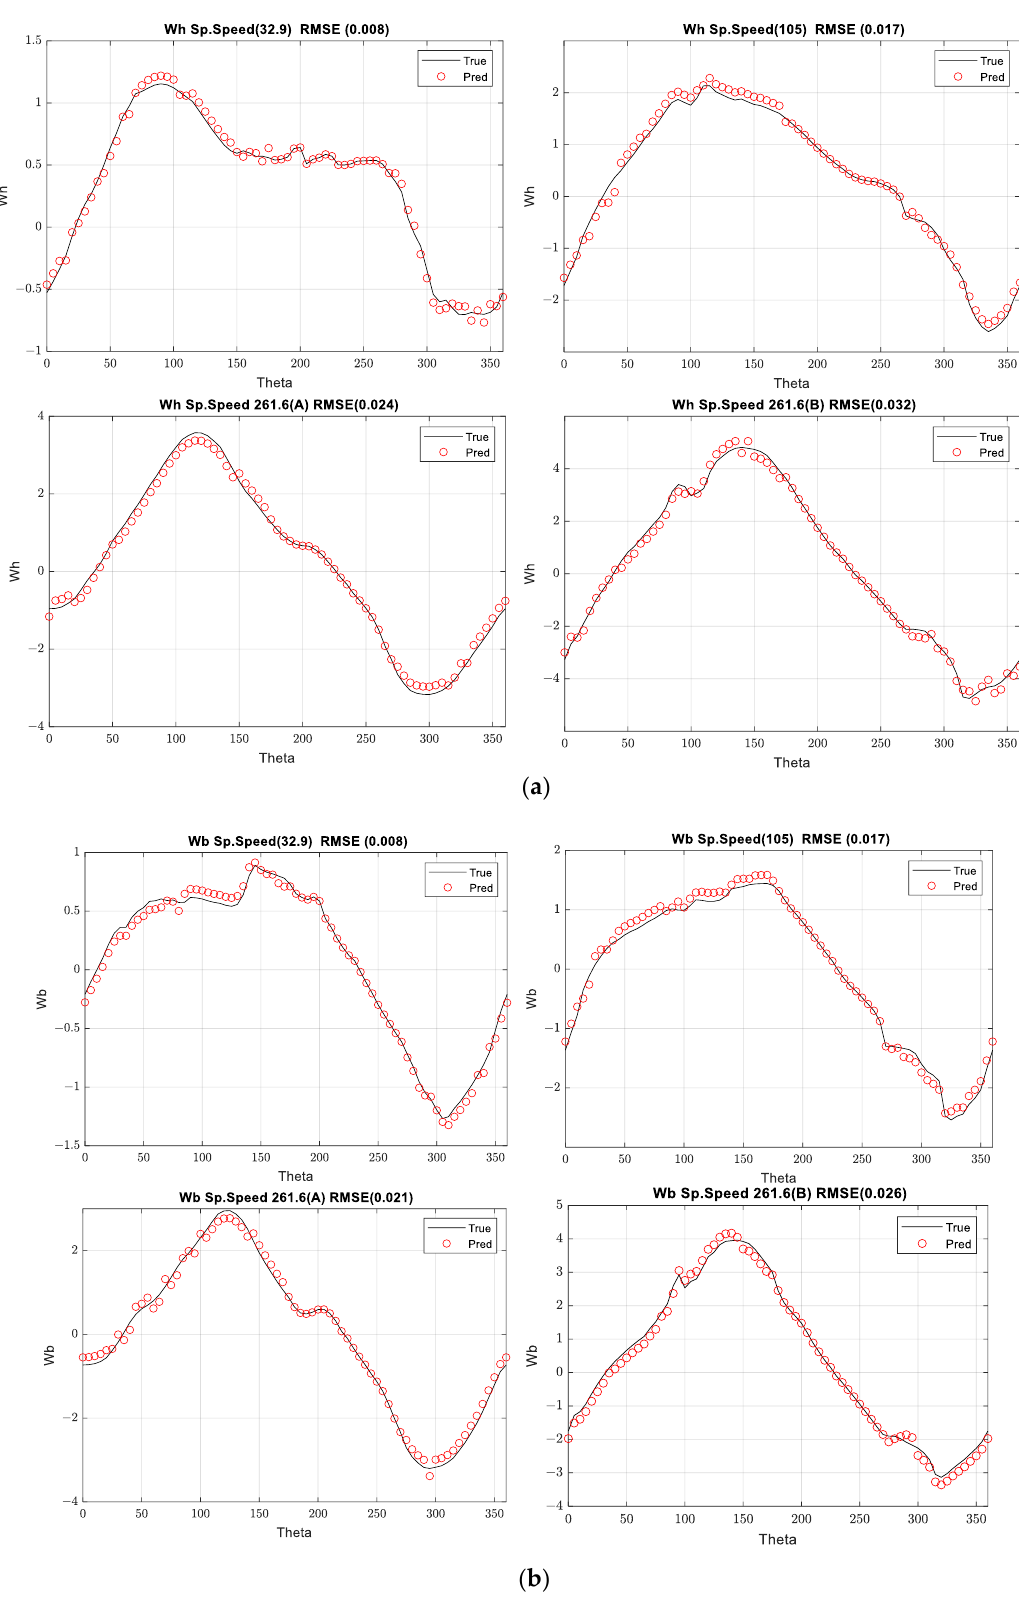
Figure 6. ( a ) Predicted dimensionless head complete pump characteristic curve plotted against actual experimental curve with respect to Table 2. ( b ) Predicted dimensionless torque complete pump characteristic curve plotted against actual experimental curve with respect to Table 3.